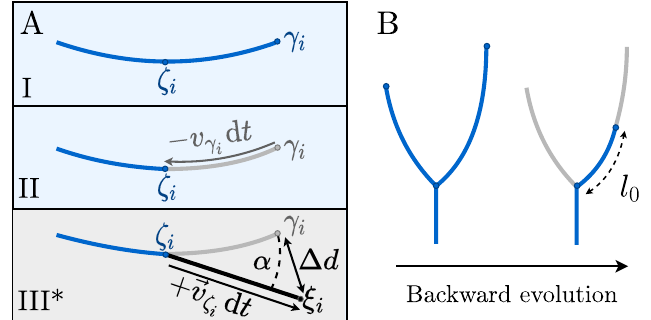
Figure 5. The Backward Evolution Algorithm. ( A ) I–II: The velocities of the tips ( γ i ) are calculated, and each branch is trimmed by v γ i d t . This gives the previous tip positions ζ i , where we measure the local symmetry parameter ( a 2 / a 2 1 ). III ∗ : Additionally, we can use the forward algorithm to obtain an extrapolated position ξ i , and two additional metrics: the overshoot ( (cid:31) d —distance between γ i and ξ i ) and the angular deflection ( α ). ( B ) Definition of the length mismatch ( l 0 ) at a bifurcation during the backward